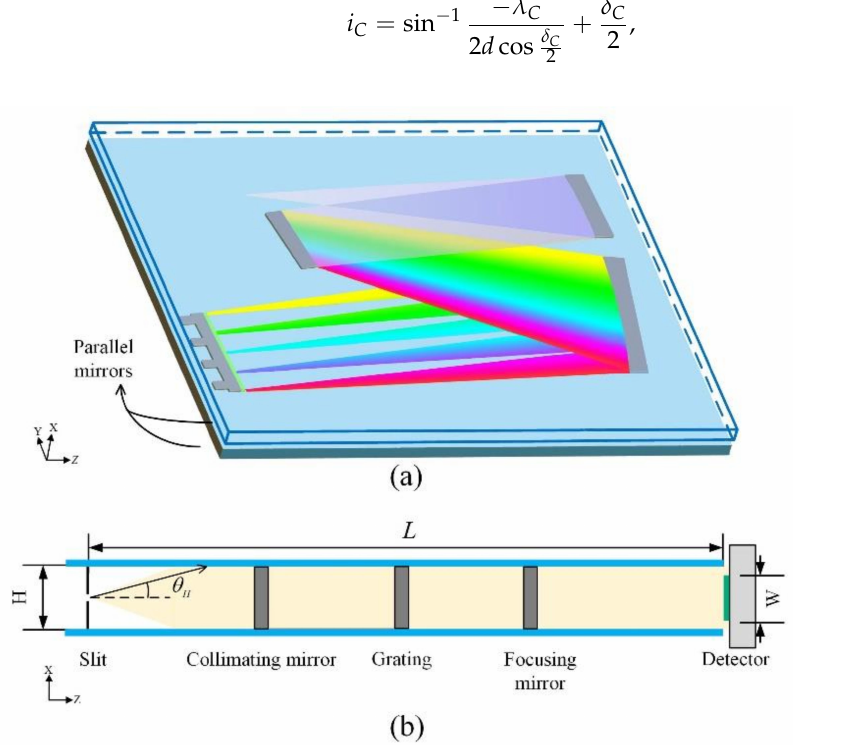
Figure 1. Schematic of an HPWS in the tangential and sagittal planes: ( a ) A C–T light path is used in the tangential plane. ( b ) The light path is folded by the two parallel mirrors in the sagittal plane, and the components appear cascaded along the light